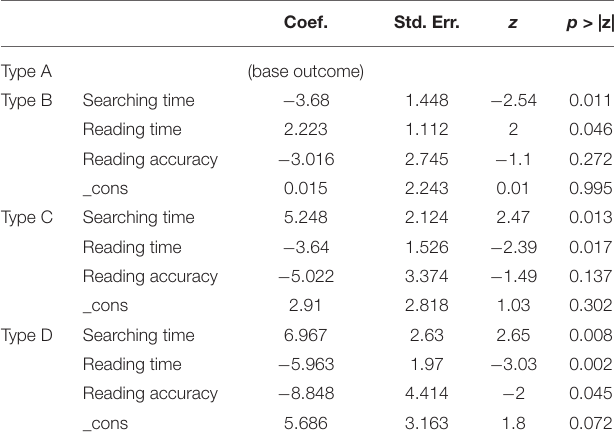
TABLE 6 | Results of the logistic regression.